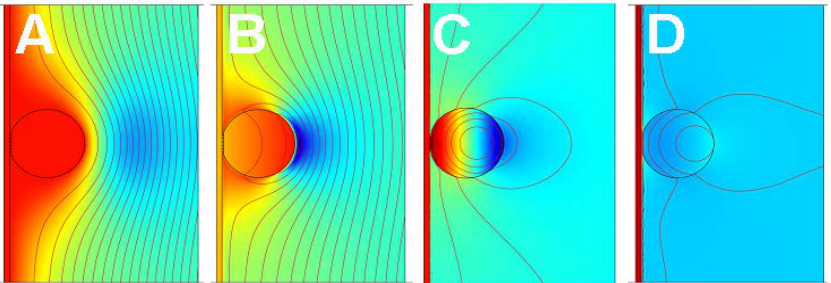
Figure 35. Velocity fields as determined with an FEM simulation in two dimensions. A cylinder attached to a plate gives rise to two coupled resonances. The diameter of the cylinder was 4 µm. The link to the substrate is 600 nm wide and 100 nm thick. Its shear modulus is 1 GPa. The colors encode the local tangential velocity. The frequencies are 1 MHz, 4.2 MHz, 54 MHz, and 90 MHz in panels ( A – D ), respectively. In panels ( A , C ), the motion of the sphere is locked to the substrate and to the bulk, respectively. The sphere forms an inertial load in ( A ) and an elastic load in ( D ). In panels ( B , C ), the amplitude of motion of the sphere is large. In ( B ), the sphere rotates about the contact, in ( C ) it rotates about its center. Adapted from [171].